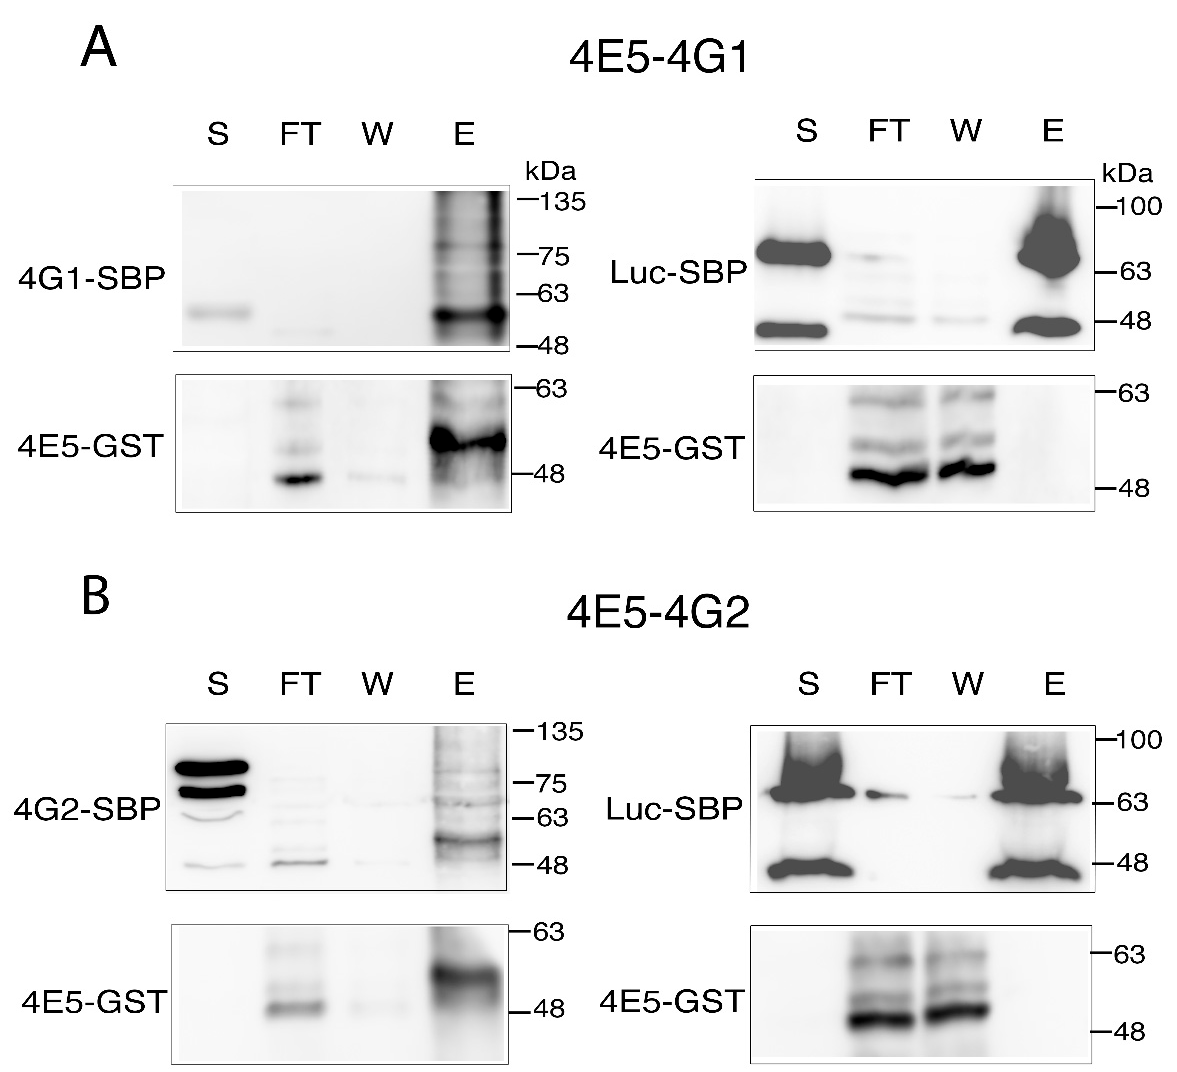
Figure 6. Recombinant LeishIF4E-5-GST interacts directly with LeishIF4G-1 and LeishIF4G-2. Lysates of Leishmania cell lines expressing SBP-tagged LeishIF4G-1 or LeishIF4G-2 were bound to Streptavidin beads, followed by incubation with E. coli cell lysates expressing recombinant GST-tagged LeishIF4E-5. After several washes, the final elution was carried out with 5 mM Biotin. Leishmania cell line expressing SBP-tagged luciferase was used as a negative control. Aliquots obtained from the supernatant (S, 2%), the flow-through (FT, 2%), the wash (W, 25%) and the eluted fractions (E, 25%) were resolved over 12.5% SDS-PAGE, and subjected to Western blot analysis with specific monoclonal antibodies against the SBP and GST tags. ( A ) LeishIF4E-5-GST interacts directly with LeishIF4G-1. The top panels represent the blot developed with anti-SBP antibodies while the bottom panels represent the blot developed with anti-GST antibodies. ( B ) LeishIF4E-5-GST interacts directly with LeishIF4G-2-SBP. The top panels represent the blot developed with anti-SBP antibodies while the bottom panels represent the blot developed with anti-GST